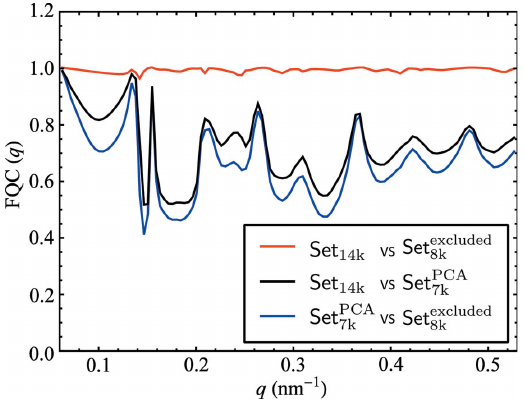
Figure 8 Comparative analysis of different pairs of the selected data sets by the Fourier quadrant correlation (FQC) approach.